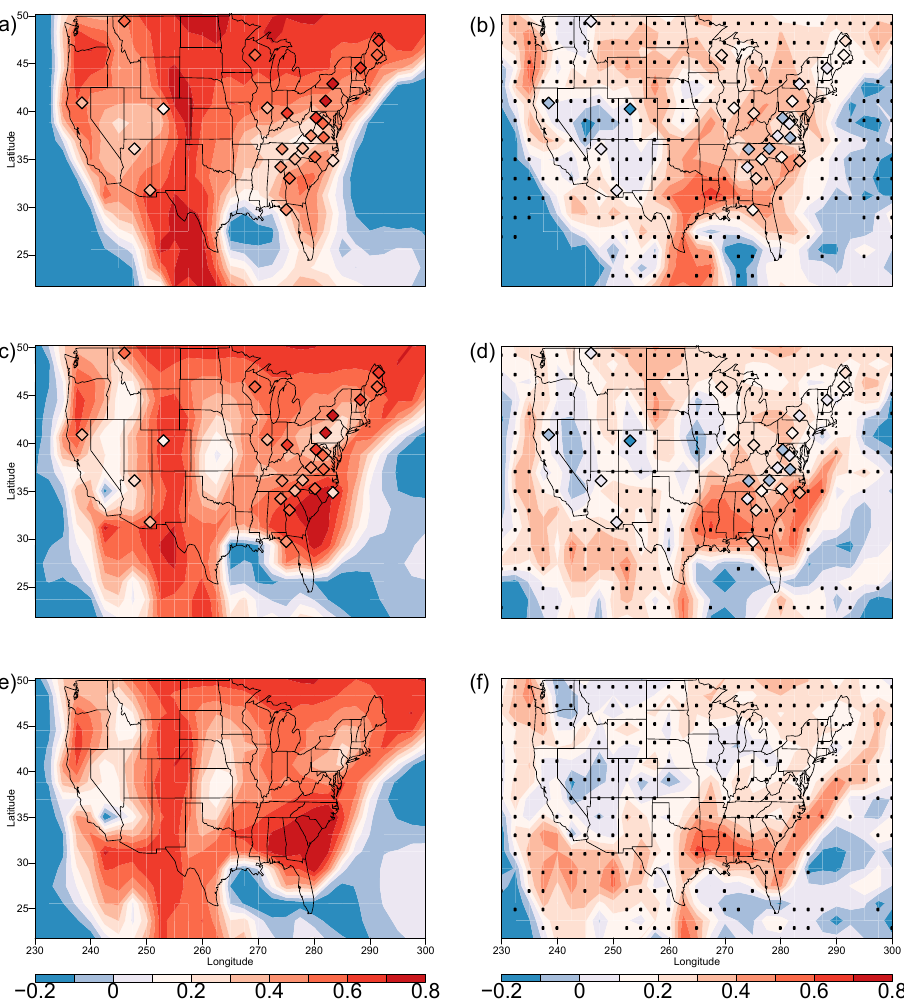
Figure 6. Normalized data. Unconditional correlations between maximum daily temperature and MDA8 ozone (a, c, e) ; correlations between maximum daily temperature and MDA8 ozone conditional on maximum daily temperature greater than the 90th percentile (b, d, f) , for the CESM1 REFC1SD simulation (1992–2010) (a, b) , the GCM2000 simulation (2006–2025) (c, d) and the GCM2100 simulation (2106–2125) (e, f) . The unconditional and conditional correlations from CASTNET measurements (1992–2011) are shown as filled diamonds in the first two rows. The black dots in the right panels indicate the significant changes from the unconditional to conditional correlations.